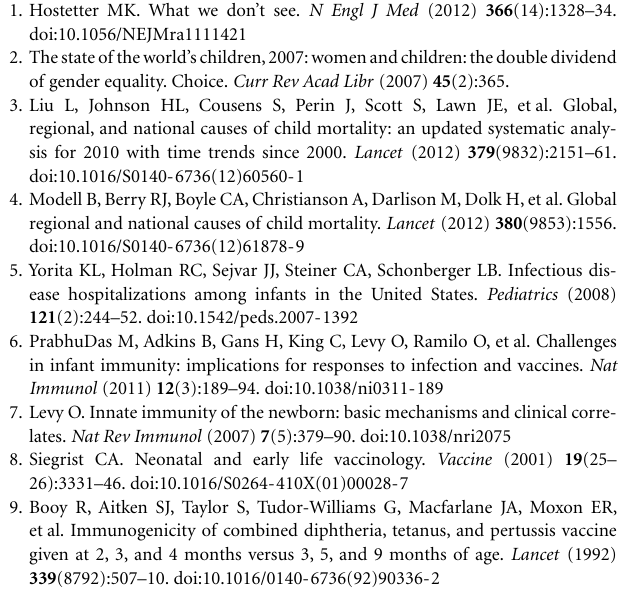
FIGURE 3 | Proposed mechanisms of CD71 + erythroid cells-induced gut immune-regulation in full term versus preterm newborns . In full terms, enriched CD71 + erythroid cells generate a suppressed immune environment by regulatory andTh2 type cytokine in the intestine, which down-regulatesTLR expression, maintains symbiosis and intestinal